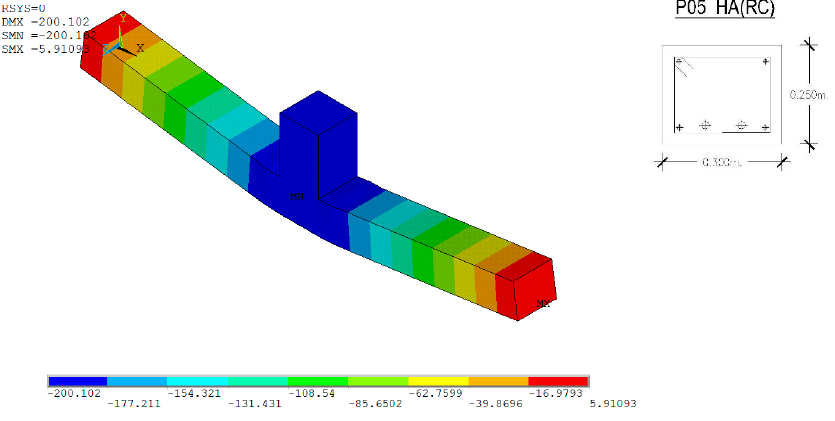
Figure 24. Deflections in the beam (in mm).